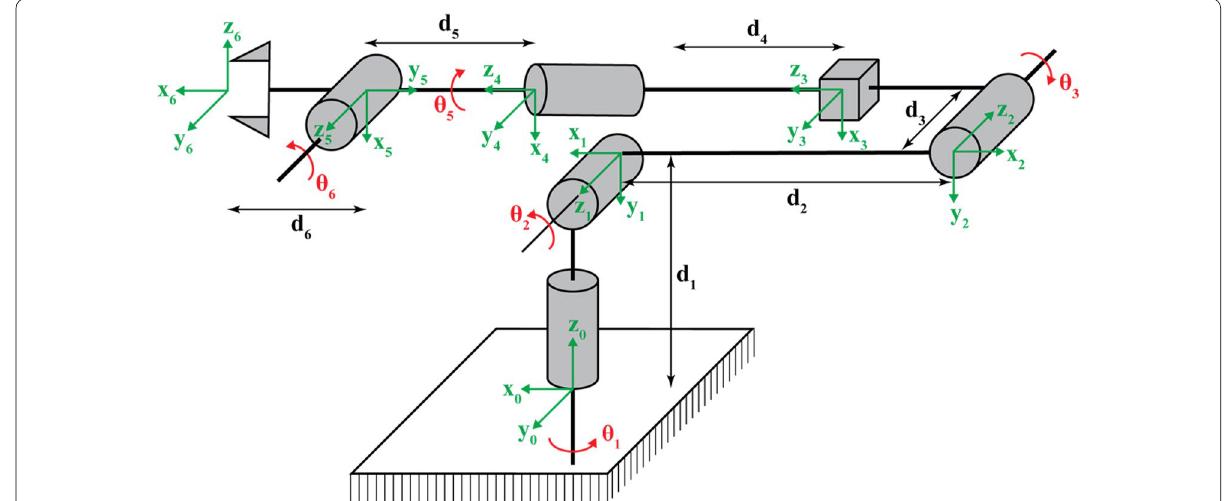
Fig. 5 Conceptual design of the 7-DOF arm, presented with kinematic parameters and frame assignments